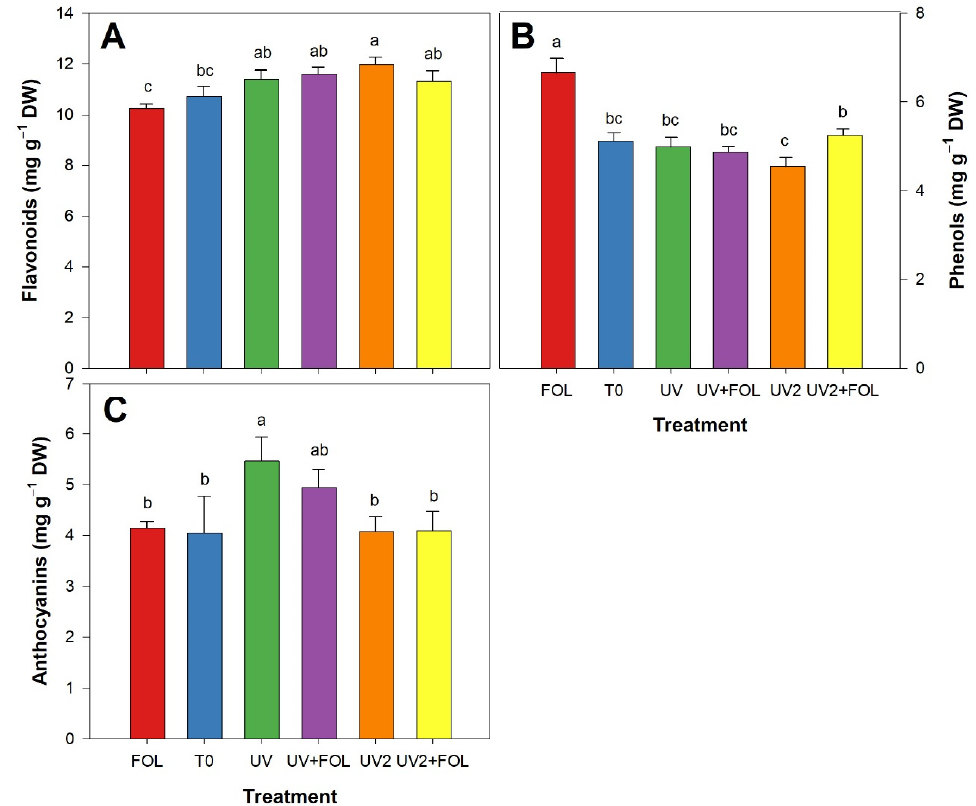
Figure 5. Contents of secondary metabolites in leaves of tomato plants inoculated with Fol and supplemented with UV-A radiation. ( A ) Flavonoids, ( B ) Phenols, and ( C ) Anthocyanins. The leaf samples (fully expanded young leaves) were collected 17 weeks after transplanting. Different letters between treatments indicate significant differences according to Fisher ´ s Least Significant Difference test ( p < 0.05). n = 6 ± standard error. T0, negative control (tomato plants without UV-A radiation and without Fol inoculation); FOL, positive control (tomato plants only inoculated with Fol); UV, tomato plants supplemented with UV-A radiation through one LED lamp; UV + FOL, tomato plants supplemented with UV-A radiation through one LED lamp and inoculated with Fol; UV2, tomato plants supplemented with UV-A radiation through one LED lamp above the plant canopy plus one fi xed lamp at the bo tt om of the plants; and UV2 + FOL, tomato plants inoculated with Fol and supplemented with UV-A radiation through one LED lamp above the plant canopy plus one fi xed lamp at the bo tt om of the plants.